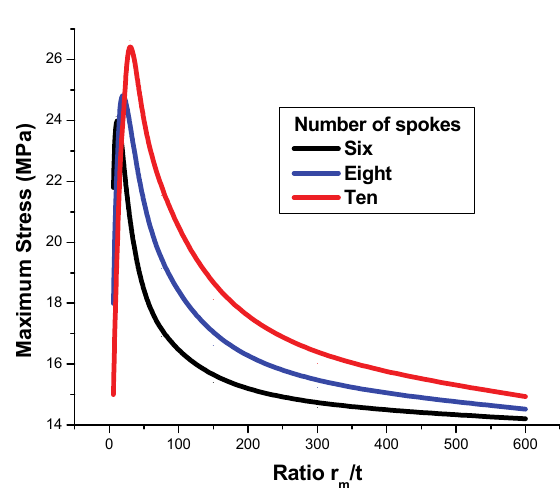
Fig.6. Maximum stress against ratio r m / t for three flywheel impellers Figure 6. Maximum stress against ratio r m /t for three flywheel im- pellers.